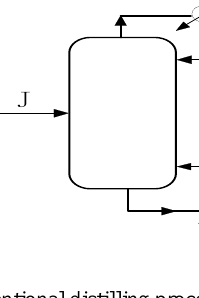
Fig. 1. Conventional distilling process schematic diagram J -input quantity(kmol·h -1 ), D -distillate quantity(kmol·h -1 ), W -residue quantity(kmol·h -1 ), T 0 -ambient temperature( ), ℃ T B -reboiler temperature( ℃ ), T C -condenser temperature( ). ℃